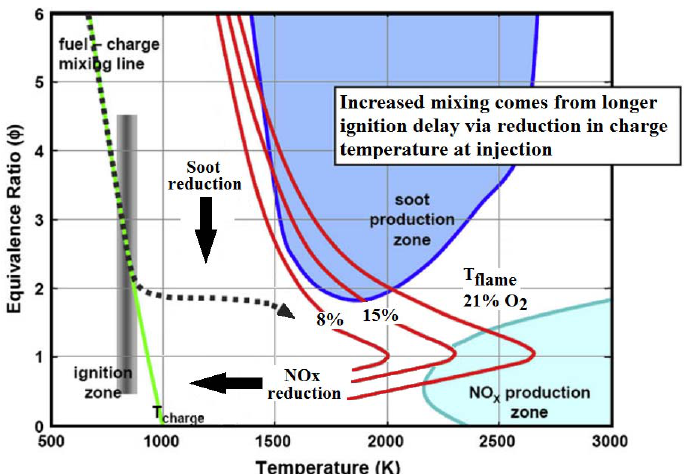
Figure 1. Diesel combustion